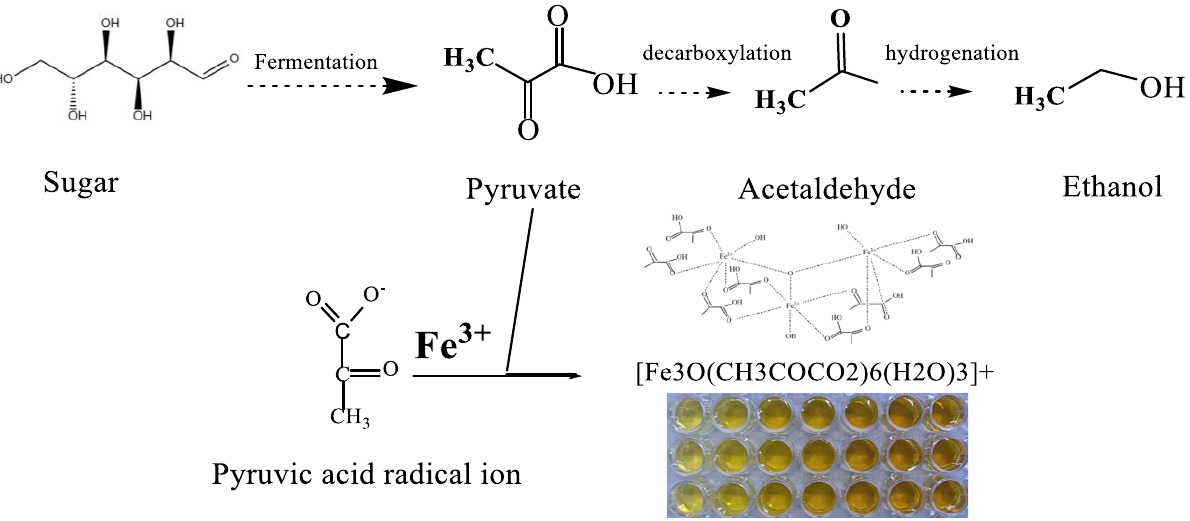
Figure 1. Schematic diagram of Py-Fe3+ high-throughput screening principle. Ferric nitrate can react with the pyruvate or pyruvic acid radical ion, but no other organic acids, to form a yellow complex.